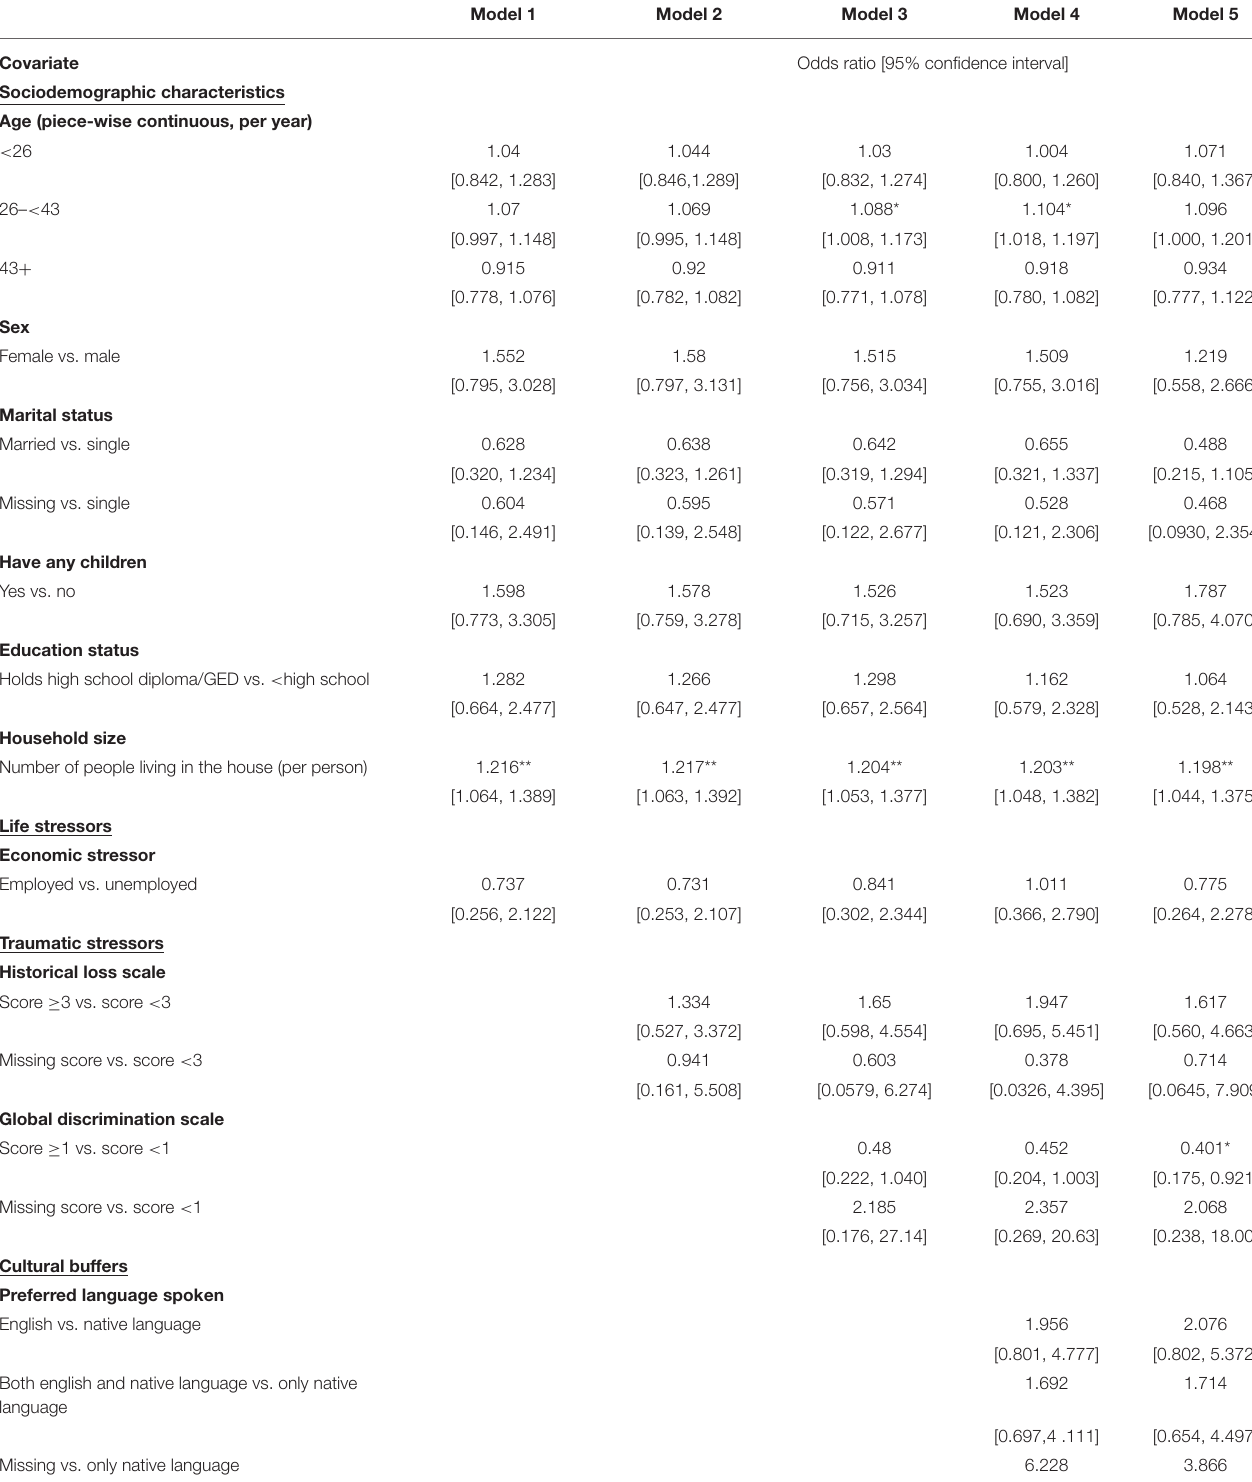
TABLE 3 | Logistic regression models for STD testing among American Indians with binge substance use in a rural